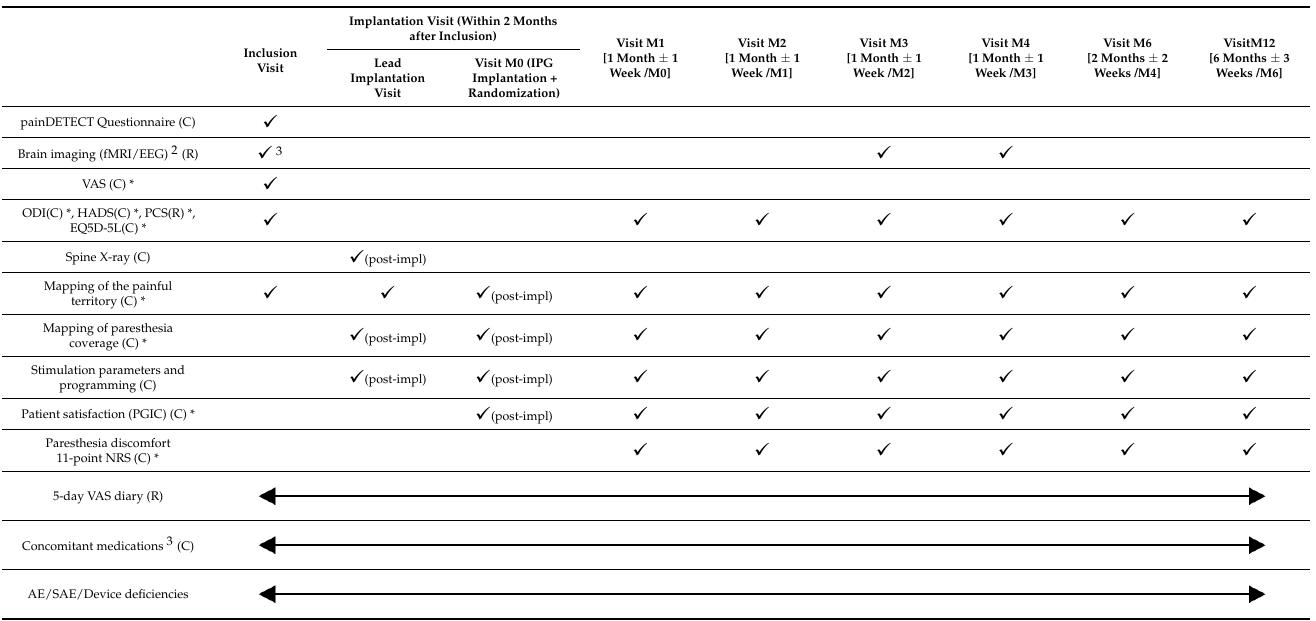
Table 1. Radio-clinical assessment calendar. Inclu-